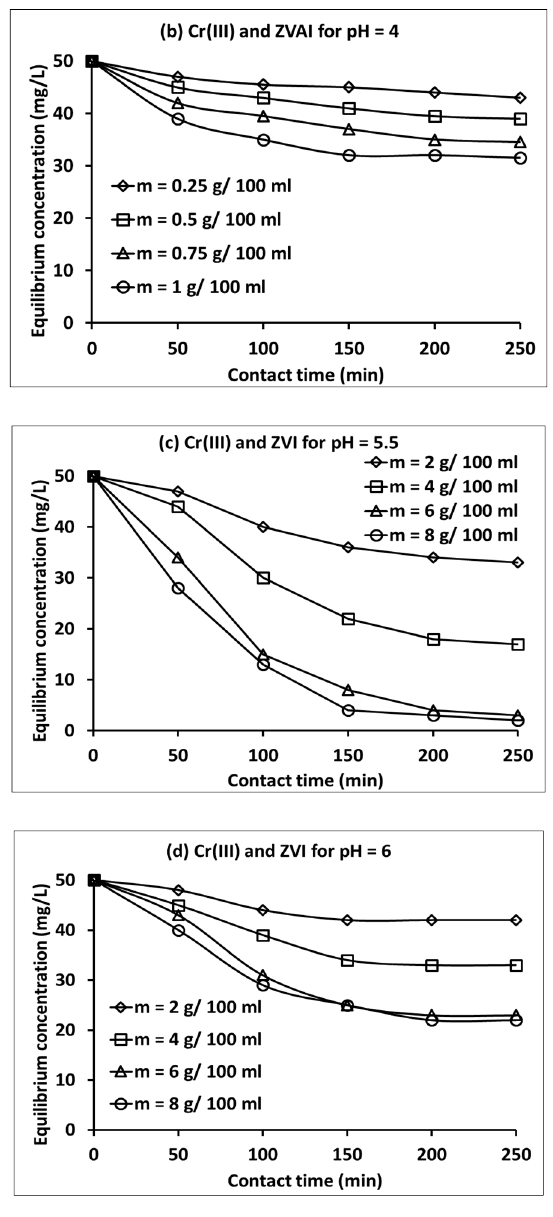
Fig. 2. Sorption of Cr(III) onto ZVI at different values of